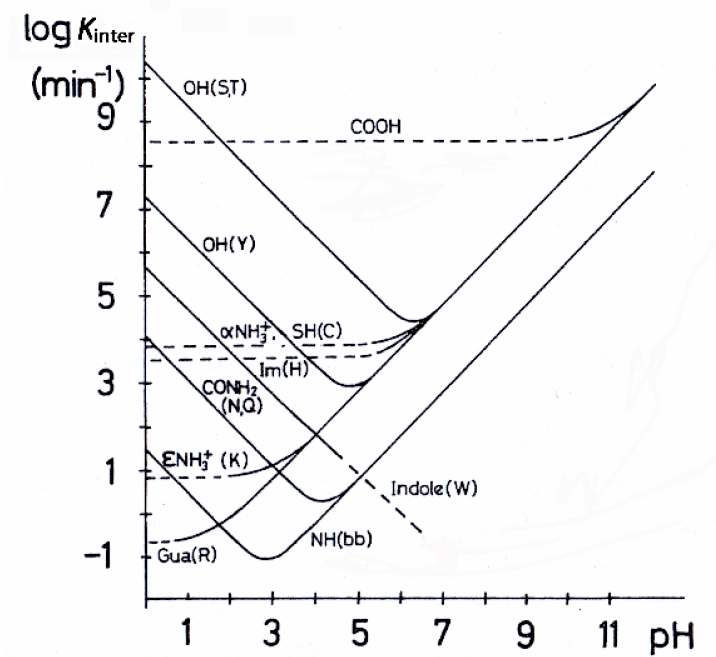
Figure 1. Effect of pH on ln k , where k is the intermolecular proton exchange rate, for inter inter various functional groups in peptides and proteins. Adapted with permission from